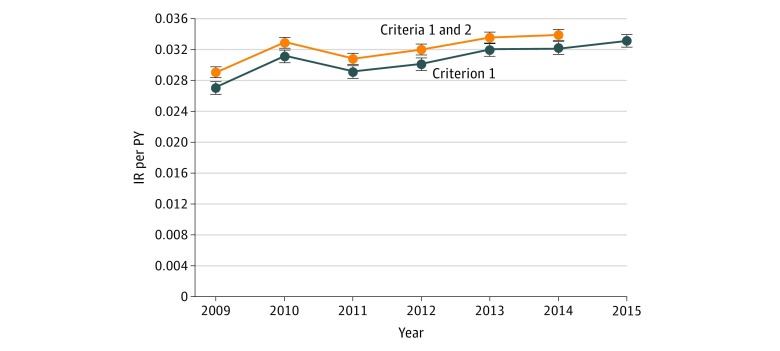
Incidence Rate (IR) per Person-Year (PY) of Atopic Dermatitis During the First 6 Years of LifeData are from the Norwegian Prescription Database from January 1, 2009, through December 31, 2015. Error bars indicate 95% CI. The upper curve displays the IR per PY determined by reimbursed (criterion 1) and nonreimbursed (criterion 2) medications as proxies for atopic dermatitis; the lower curve (year 2009-2015) displays the IR for reimbursed medication only (criterion 1).